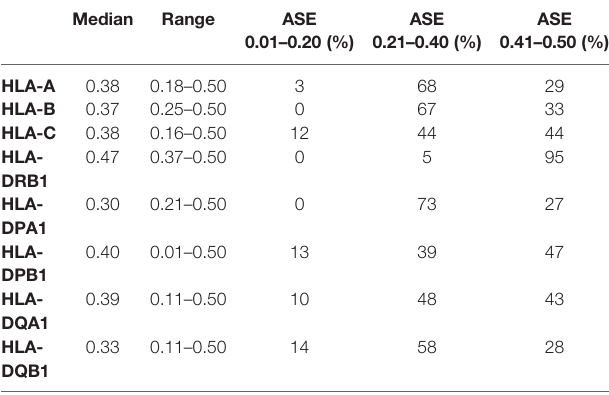
TABLE 2 | Differential allele expression between heterozygous allele pairs of eight human leukocyte antigen (HLA) genes. Proportion of the allele-speci fi c expression out of the gene-speci fi c expression* Median